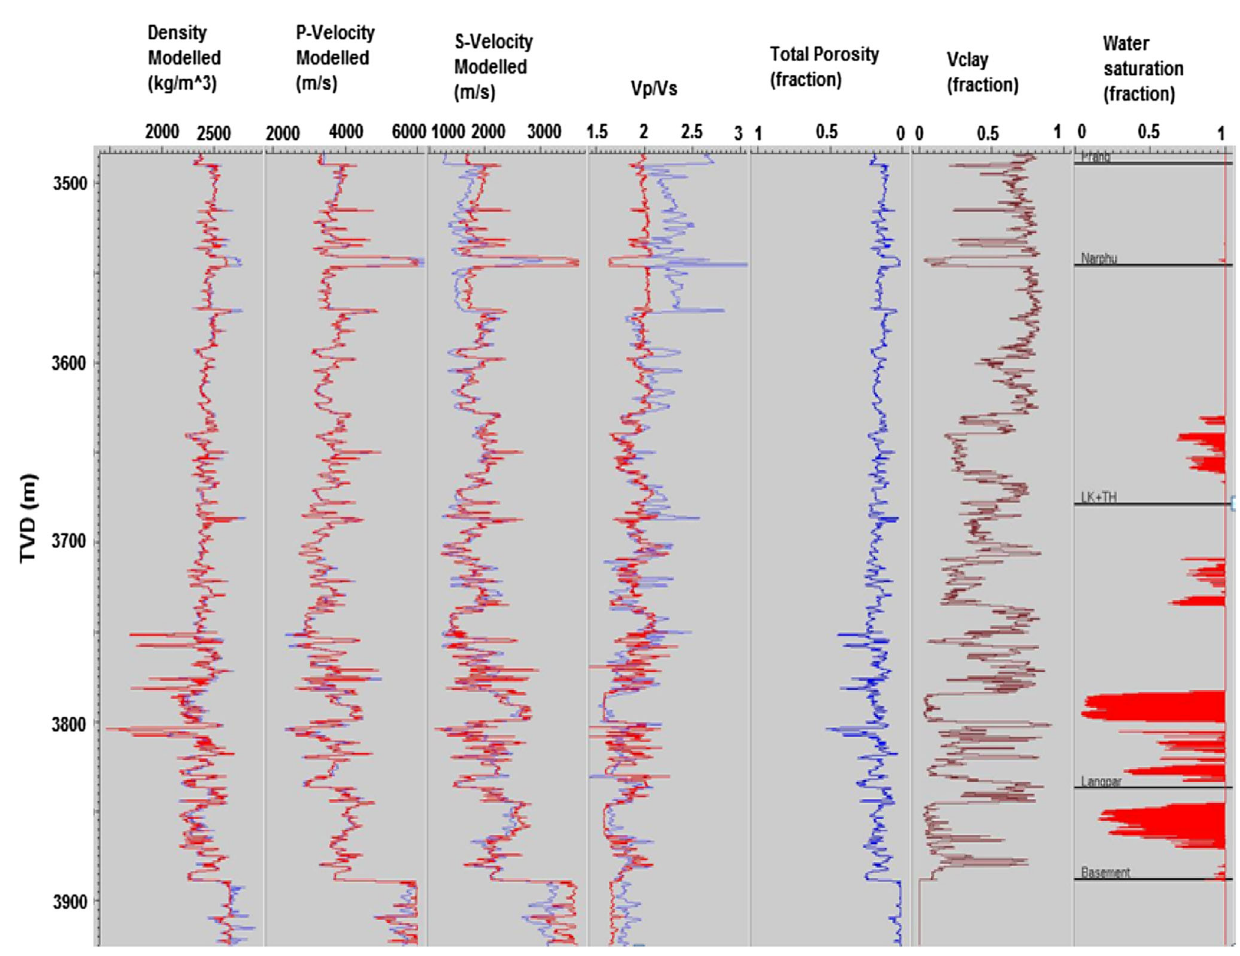
Fig. 17 A comparison of rock physics modeled log with measured log for one representative